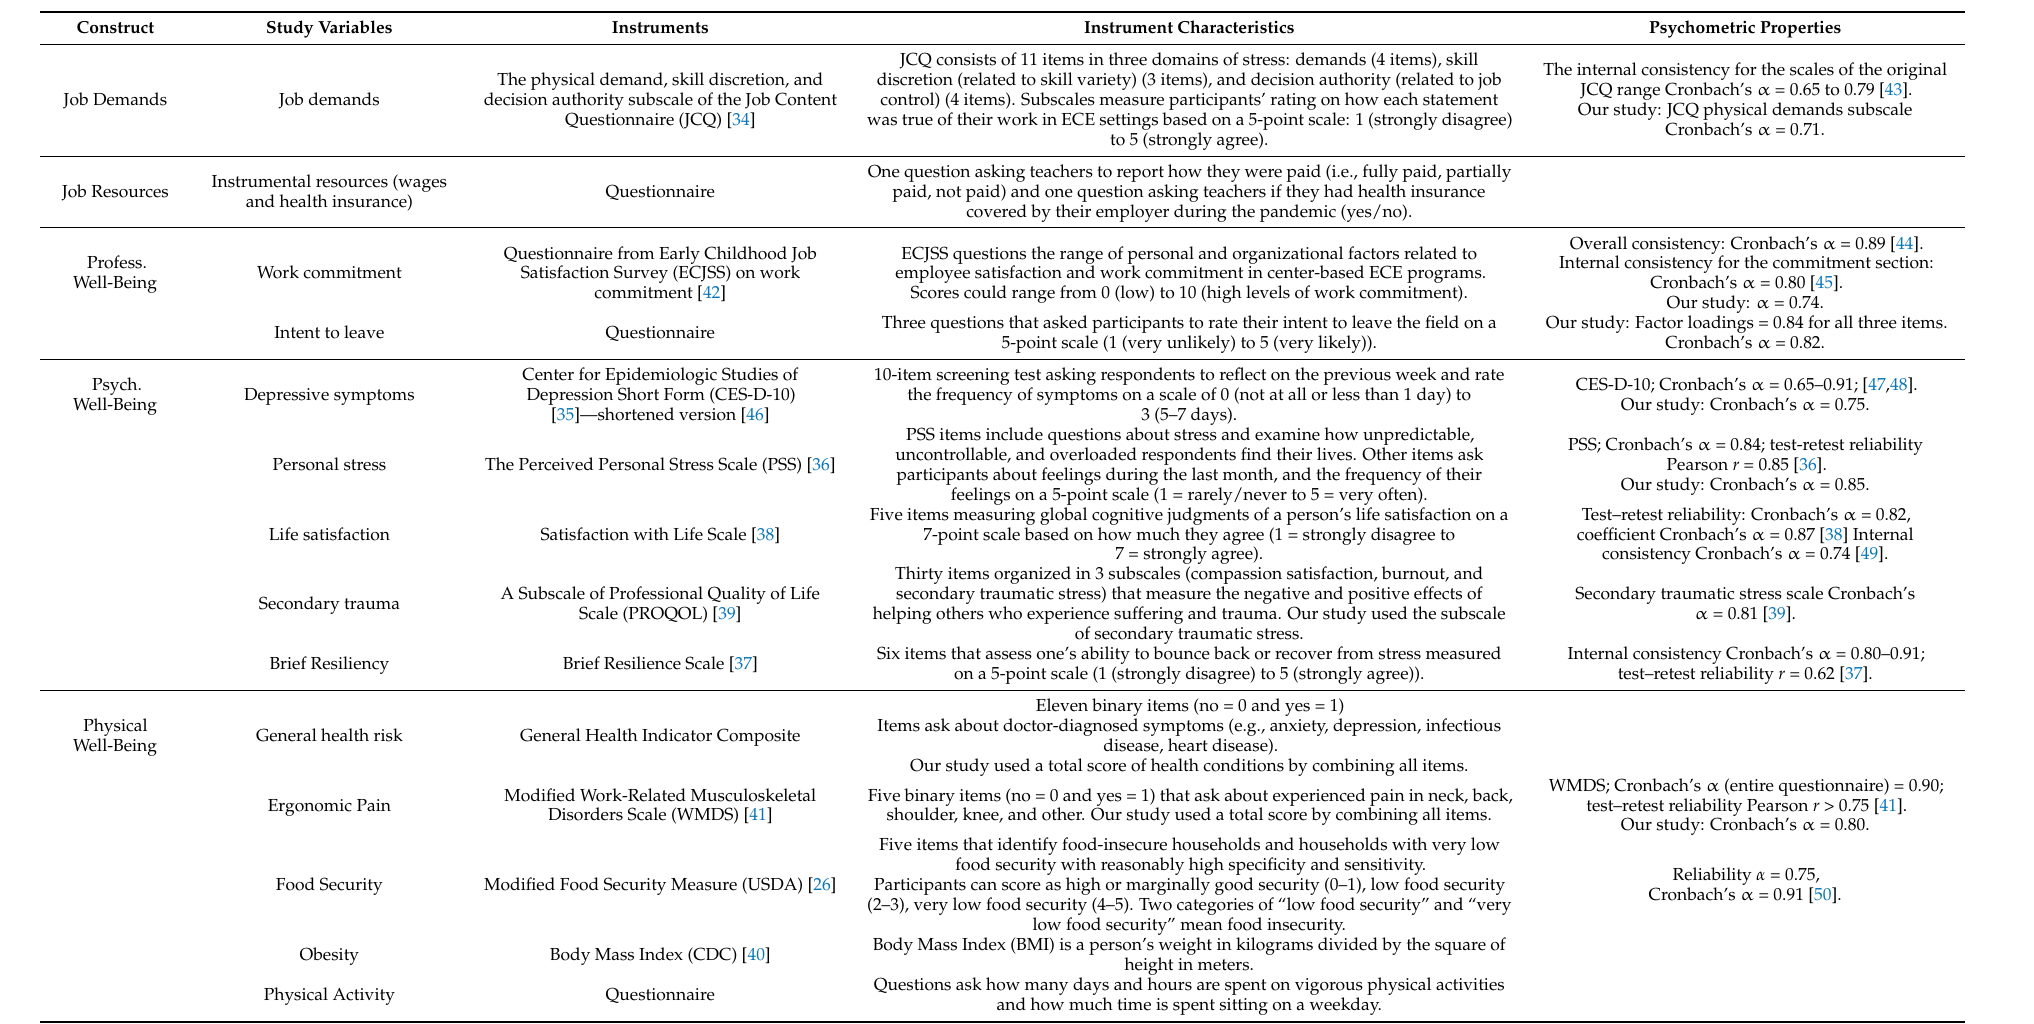
Table 1. Description of measures used in the